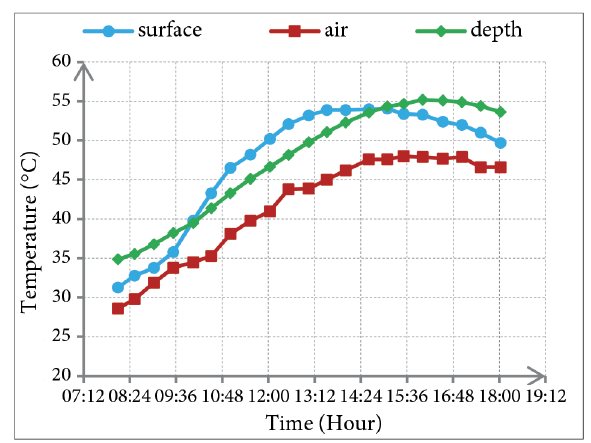
Figure 5. Air, surface and depth temperature variations in site